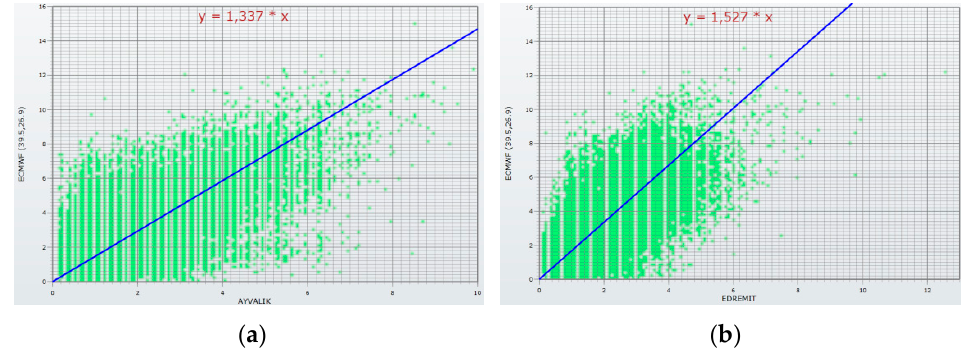
Figure 3. Correlations of wind velocities (m/s) between: ( a ) Ayvalık Meteorological Station and ECMWF operational archive for coordinates of 39.50 ◦ N–26.90 ◦ E; ( b ) Edremit Meteorological Station and ECMWF operational archive for coordinates of 39.50 ◦ N–26.90 ◦ E [33].